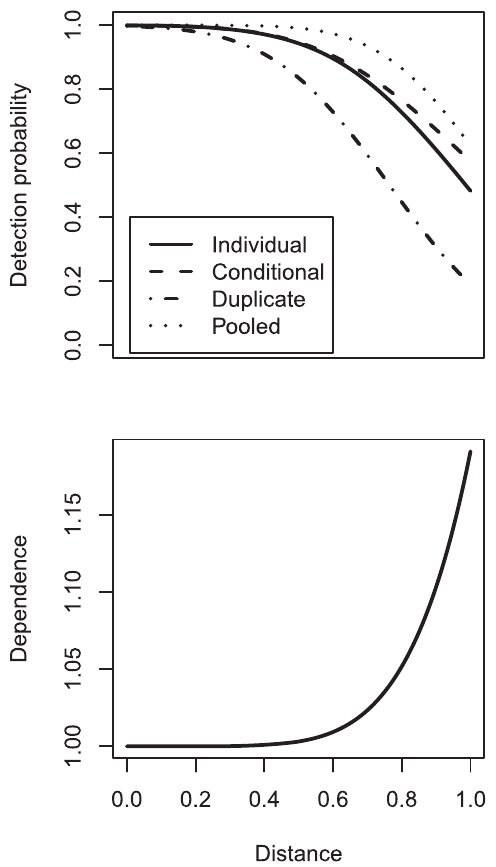
Figure 8. Implied detection probability and observer depen- dence for covariates maximizing dependence. The top panel gives detection probability curves for the set of covariates that maximize observer dependence (observer=2, group size=1, expo- sure=0, species=‘‘green’’). ‘‘Individual’’ specifies detection probability for observer 2 only; ‘‘Conditional’’ gives the probability of detection for observer 2 given that the group was detected by observer 1; ‘‘Duplicate’’ gives the probability of detection by both observers; ‘‘Pooled’’ gives the probability of detection by at least one observer. The bottom panel represents dependence, as summarized by the parameter d (see [9]) for the same set of covariates.